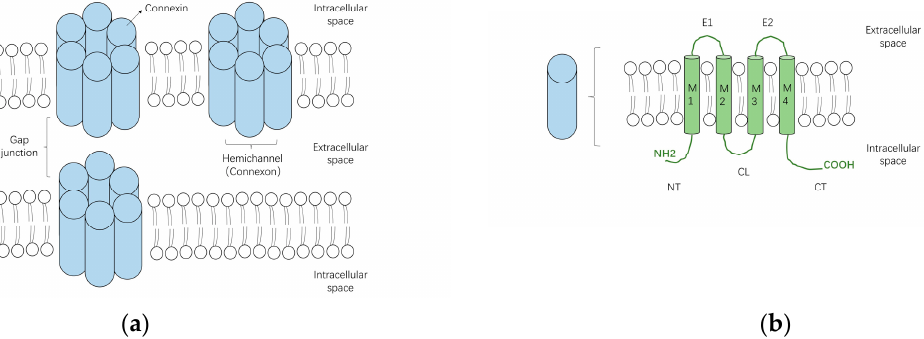
Figure 1. The schematic diagrams of gap junctions, hemichannels and connexins. ( a ) Two connexons from neighboring cells, which are formed by the oligomerization of six connexin subunits, can assemble into a gap junction. Connexons may also function as hemichannels under specific conditions; ( b ) Connexins are transmembrane proteins constituted by four transmembrane domains (M1–4) and intracellular N- and C-terminus (NT and CT), linked by two extracellular loops (E1 and E2) and one cytoplasmic loop (CL).